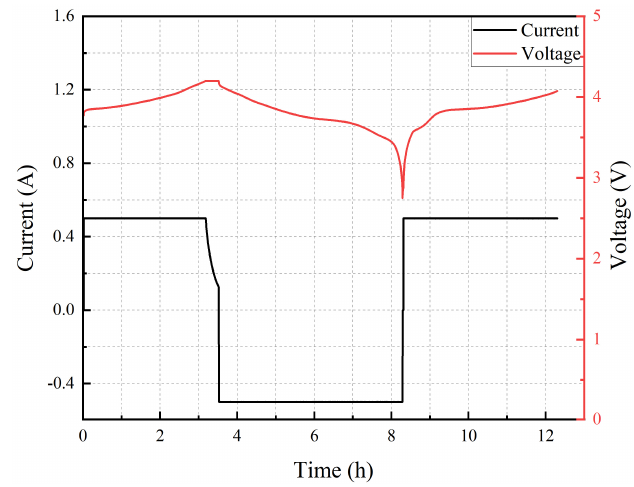
Figure 2. Charge and discharge curve of lithium − ion battery.